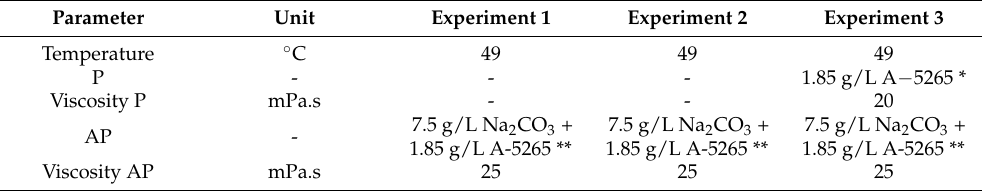
pressure was 1 bar and injection rate 1 ft/day in all